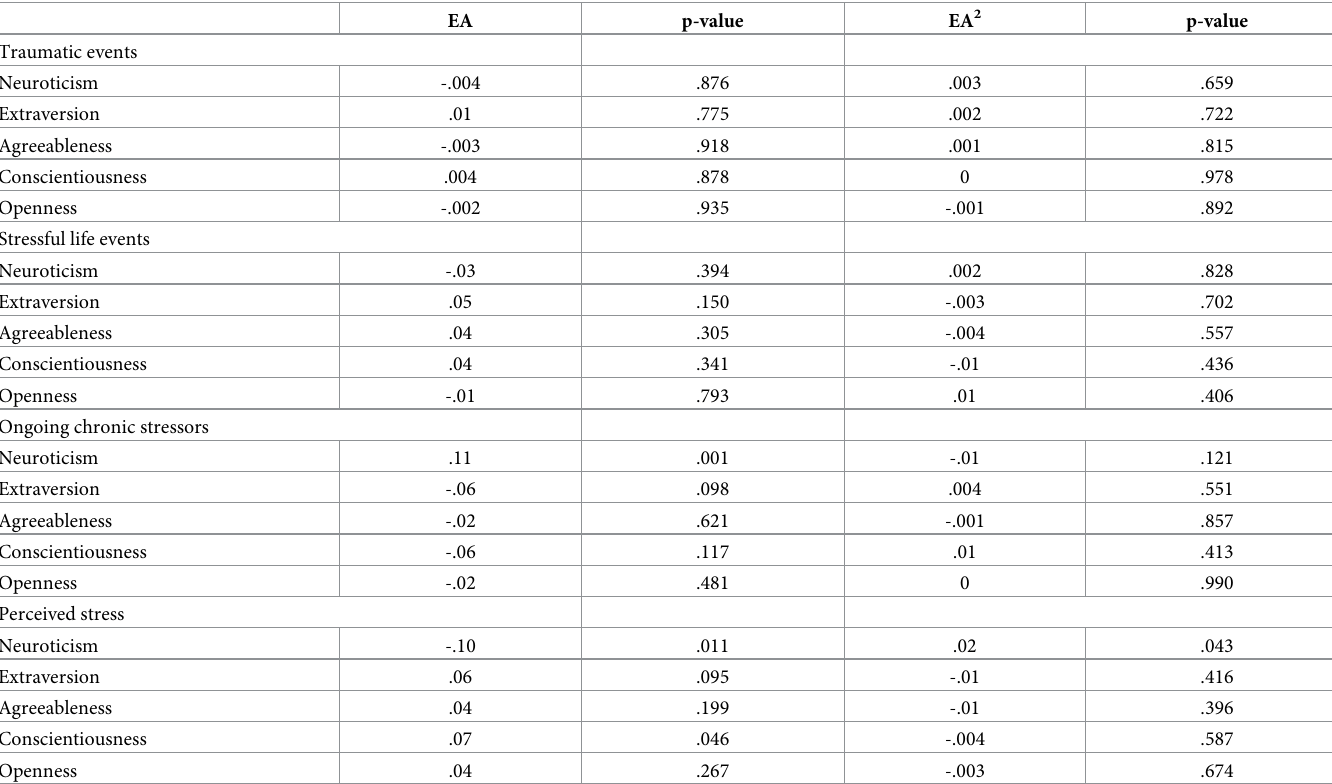
Table 5. Parameter estimates of the linear and quadratic moderating effects of early adversity on the covariances between different types of adulthood stressors exposure and adulthood perceived stress and personality traits in the HRS sample. EA p-value EA 2